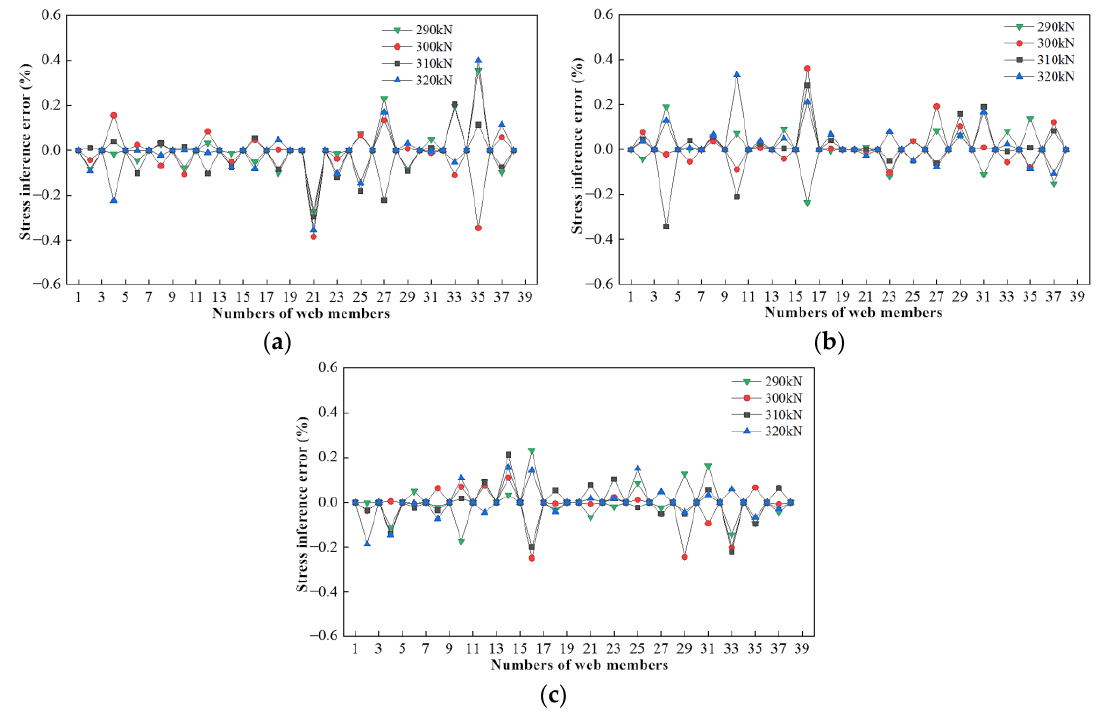
Figure 7. Stress inference error in case 2: ( a ) with the load applied on node 4; ( b ) with the load applied on node 11; ( c ) with the load applied on node 18.